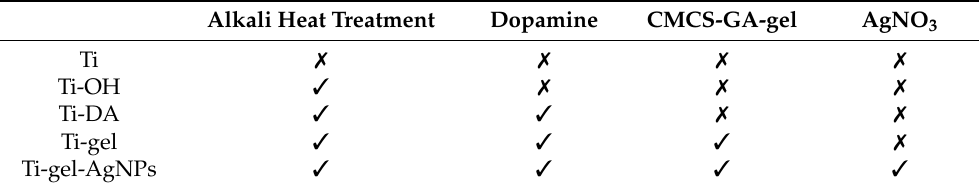
Table 1. Titanium alloy plates with different